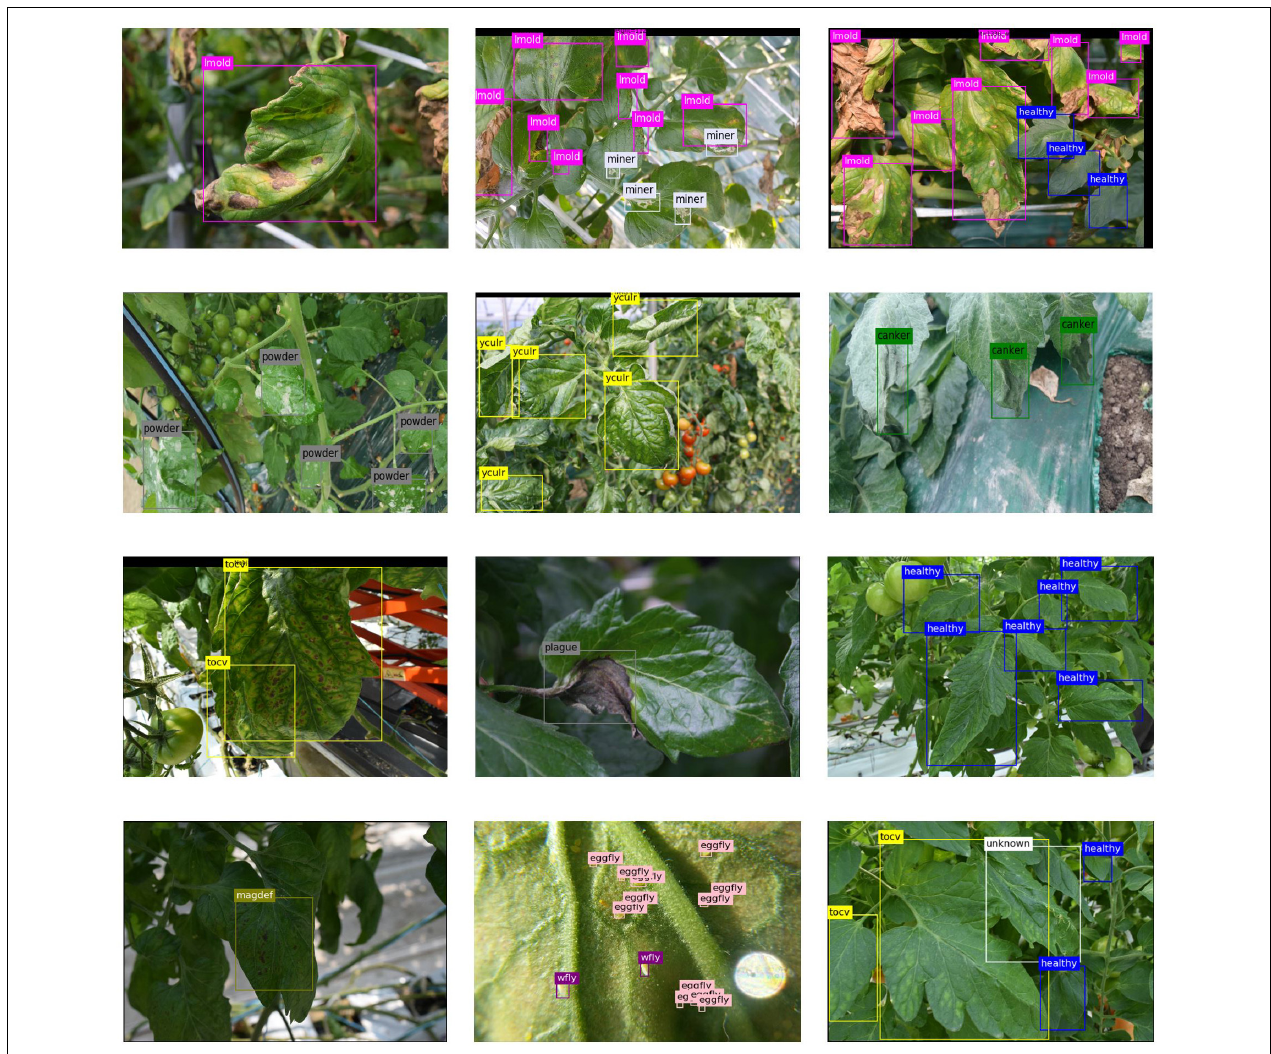
FIGURE 9 | Examples results of known and unknown classes on the tomato plant diseases and pests dataset. To obtain these results, we used an openness level of 33%. The label abbreviations represent the following classes: lmold, leaf mold; powder, powdery mildew; yculr, tomato yellow leaf curl virus (TYLCV); tocv, tomato chlorosis virus; wfly, whitefly; eggfly, whitefly eggs; magdef, magnesium